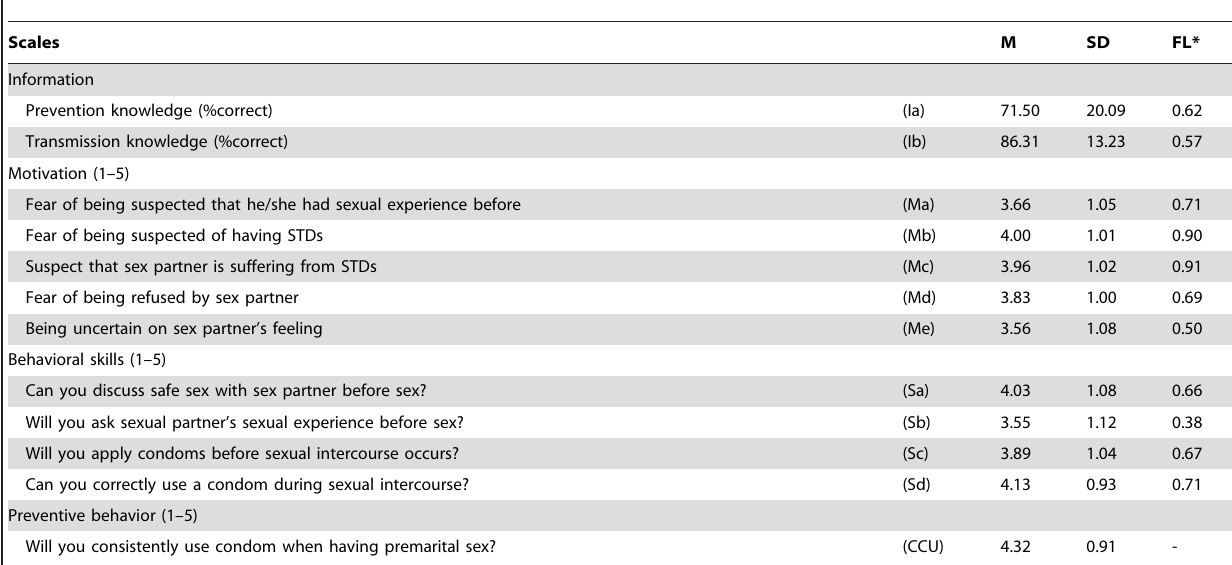
Table 2. Summary statistics and factor loadings of the IMB model in confirmatory factor analysis.